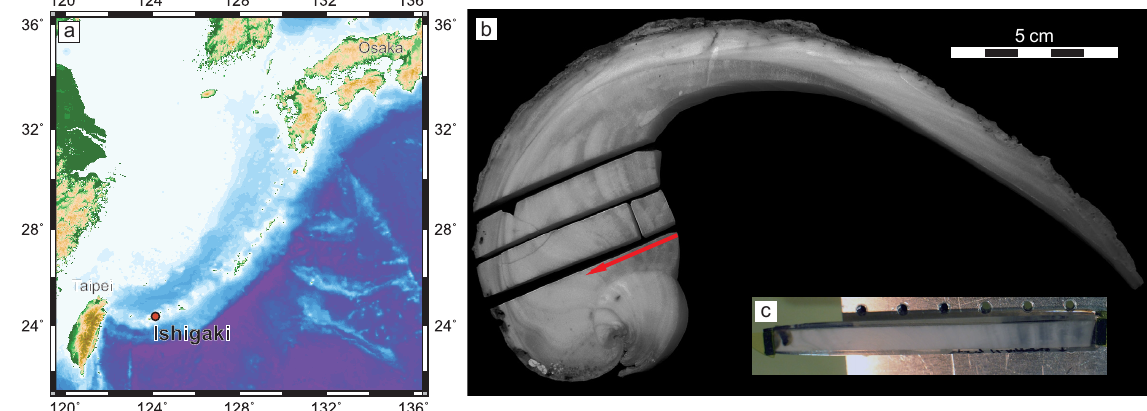
Figure 1. (a) Map of the location of Ishigaki Island, Japan. (b) A slab of the Hippopus hippopus specimen. A polished slab obtained from the inner shell layer was used for µ -XRF/XAS measurements. The red arrow indicates the measurement transect. (c) The polished slab was fixed in an aluminum sample holder with conductive double-sided carbon tape and inserted into the vacuum chamber.